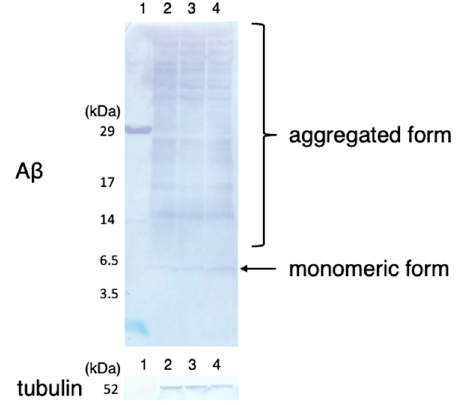
sent the mean ± SD of three independent experiments (n = 3).